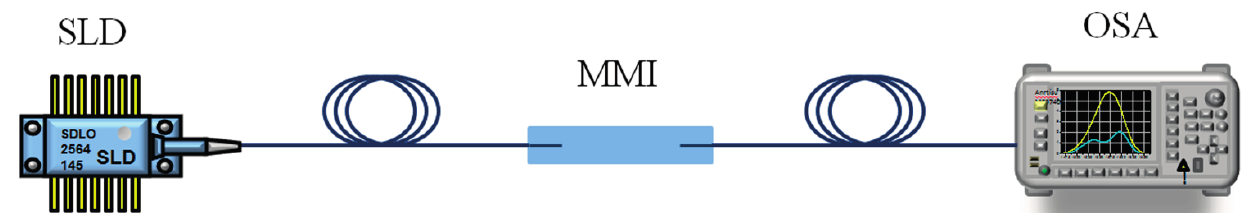
Figure 2. Experimental setup for gasohol measurements.